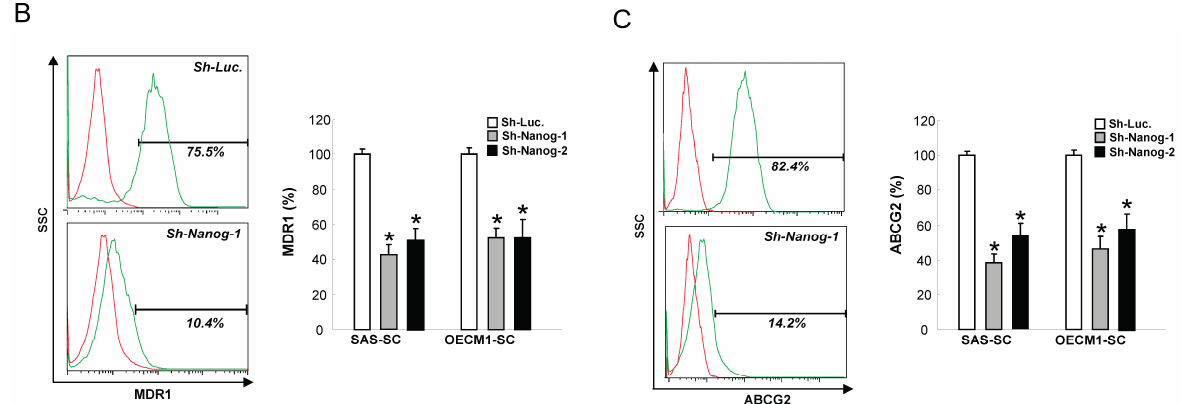
Figure 4. Synergistic effect of targeting Nanog combined with of cisplatin treatment decreased